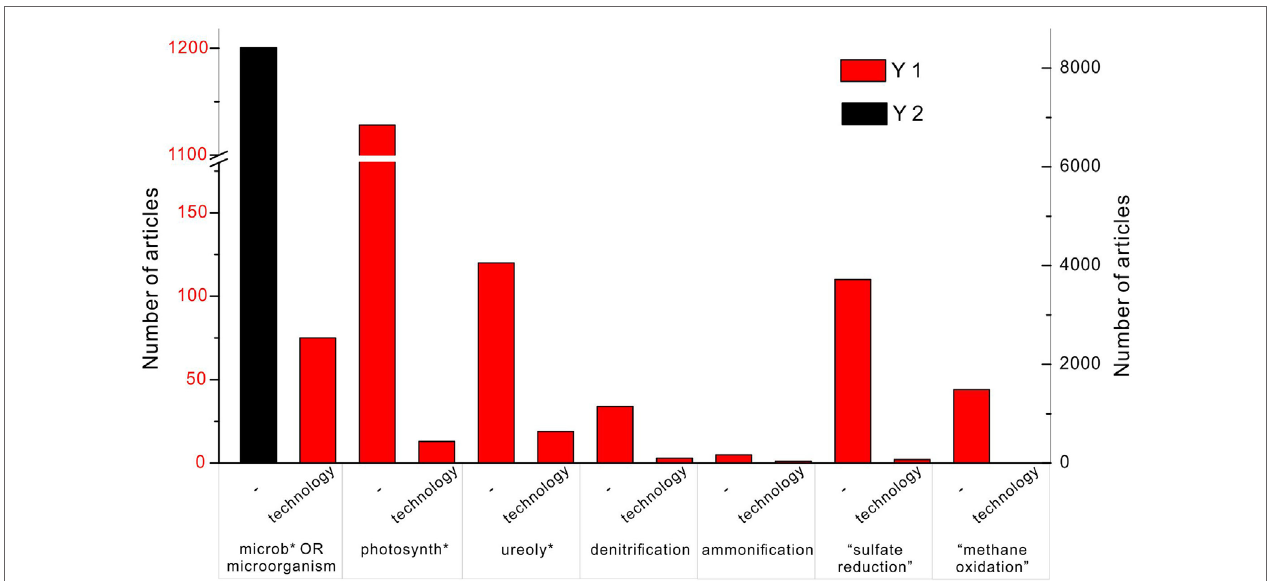
FiGURe 1 | Number of articles on the topic of “carbonate precipitation” OR “calcite precipitation” OR “calcification” in the database of web of Science of all years. The black column represents the search with an additional keyword “microb* OR microorganisms,” and corresponds to the y -axis on the right side. The red column indicates the number of publications found with an additional keyword “technology,” and corresponds to the y -axis on the left showing 75 articles. Among published work, carbonate precipitation induced by photosynthesis, ureolysis, and sulfate reduction are well studied with 1128, 120, and 110 articles, respectively. Technologies of microbial carbonate precipitation are commonly based on photosynthesis and ureolysis, with 13 and 19 articles,